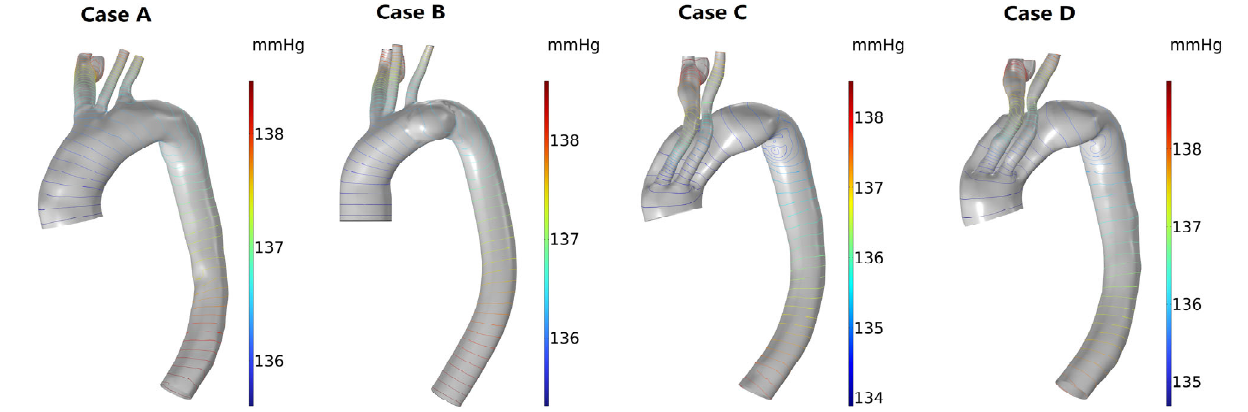
Figure 7. The pressure distribution of the four models at peak systole. (Case A ) Normal model; (Case B ) Preoperative model; (Case C ) 1-week postoperative model; (Case D ) 6-week postoperative model. WSS-based hemodynamic indicators